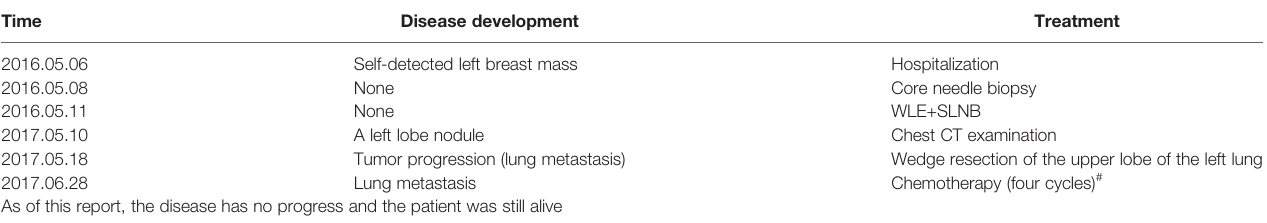
TABLE 1 | Disease development process and the treatment